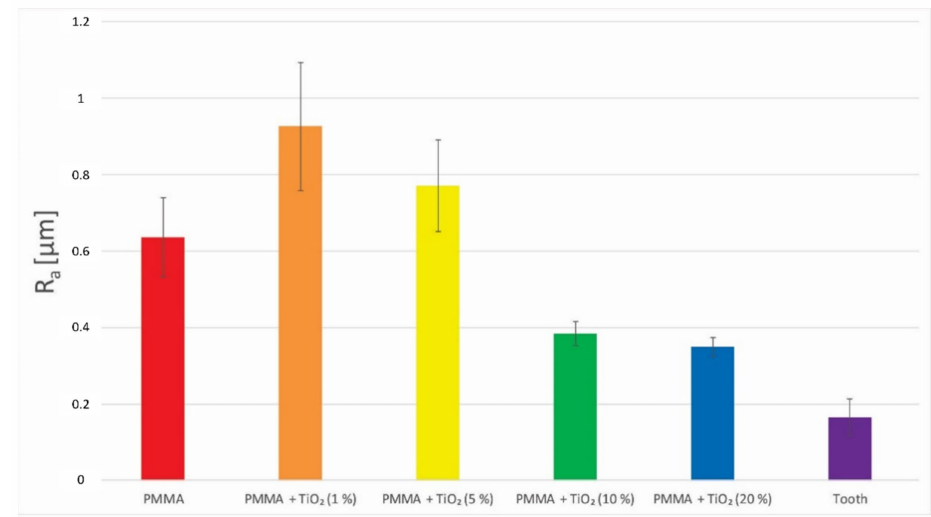
Figure 2. Arithmetic average roughness R a of surfaces measured with profilometer.